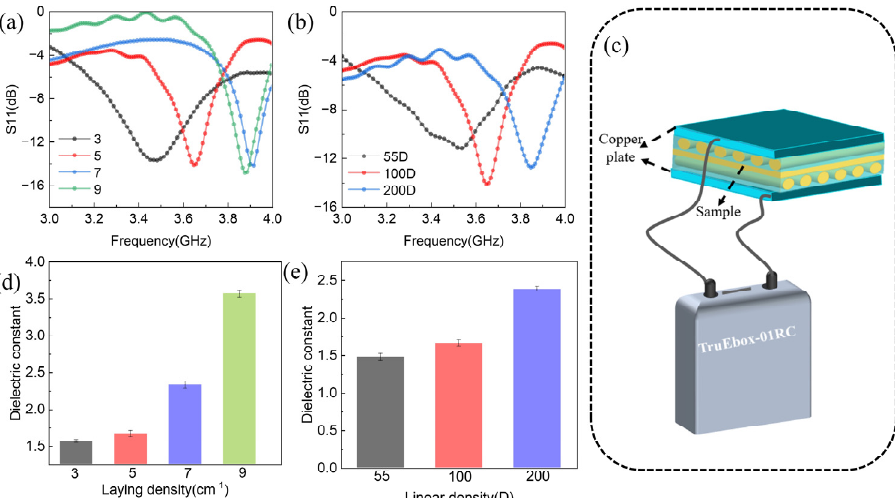
Figure 4. ( a ) Reflection coefficients (S11) of reconfigurable antennas with different fiber laying densities in state I. ( b ) Reflection coefficients (S11) of reconfigurable antennas with different fiber linear densities in state I. ( c ) Schematic diagram of the capacitance testing method. ( d ) Dielectric constants of substrate layers with different laying densities. ( e ) Dielectric constants of substrate layers with different linear densities.